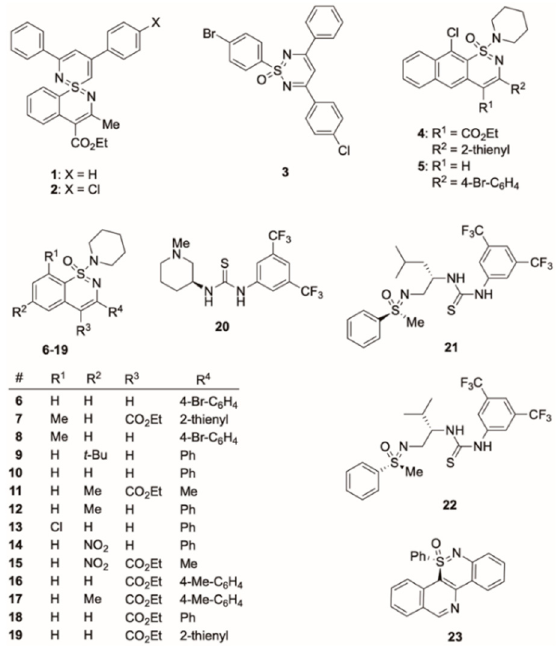
Figure 1. Structures of tested organosulfur